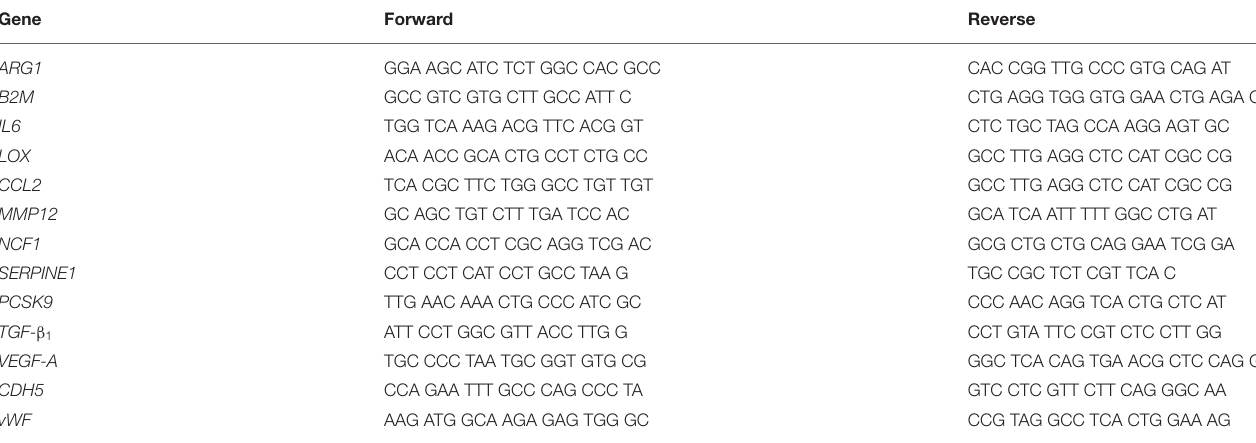
TABLE 2 | Primers used for this study.